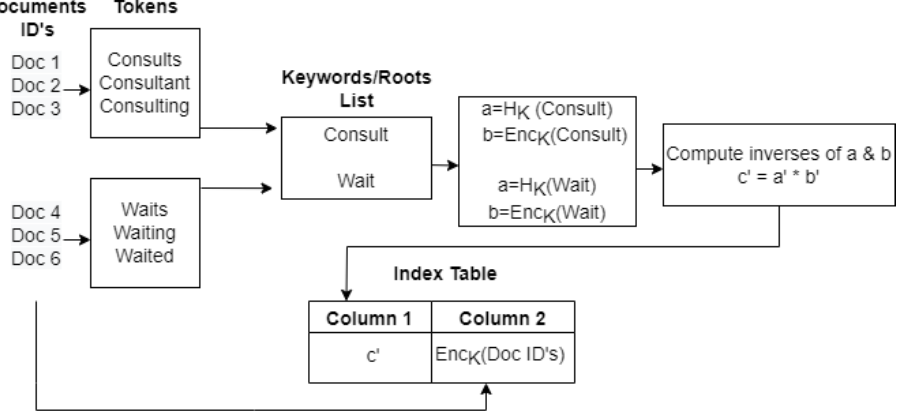
Figure 5. Toy Example-Index Generation.